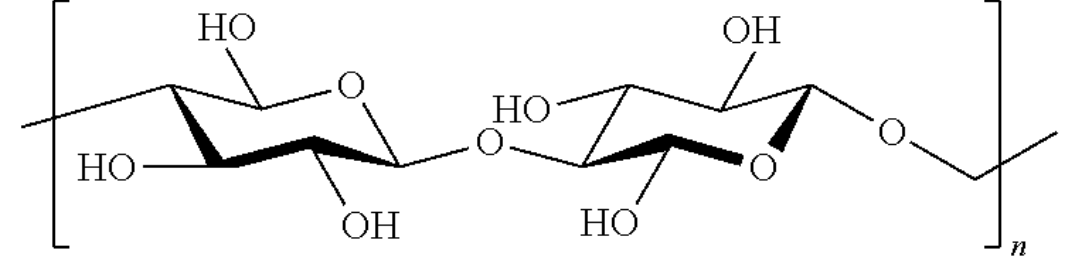
Figure 3. Hemicellulose polymer.